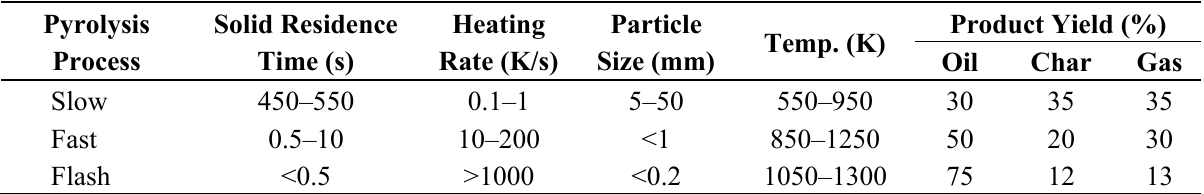
Table 1. Typical operating parameters and products for pyrolysis process